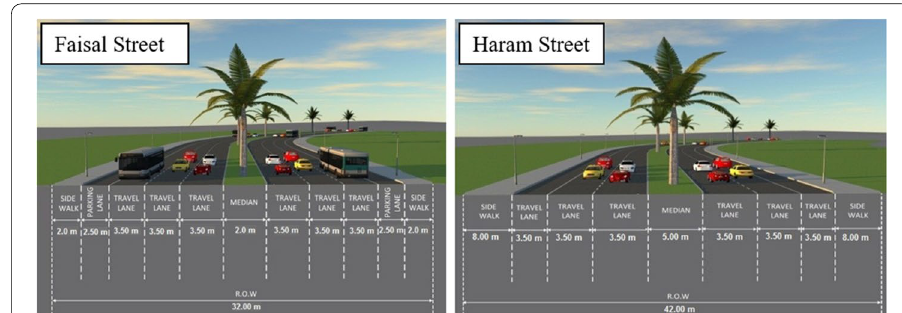
Fig. 1 Faisal and Haram Streets cross-sections